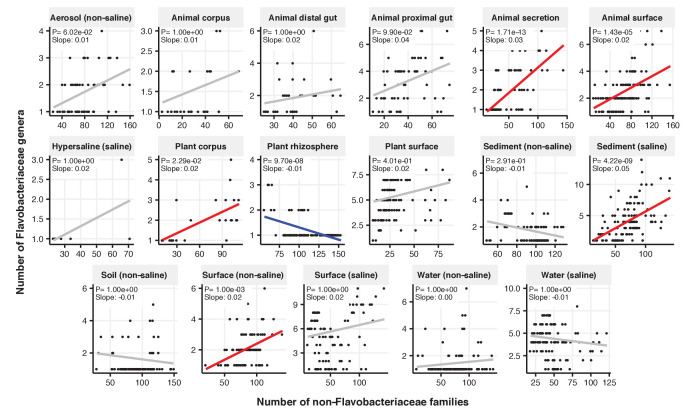
Focal-lineage diversity as a function of community diversity across biomes in Flavobacteriaceae.Linear models are shown for genera per family (y-axis) as a function of community diversity (non-focal families, x-axis) in each of the 17 environments (EMPO3 biomes). Only environments containing the focal lineage are shown. Significant positive diversity slopes are shown in red, negative in blue (linear models, p<0.05, Bonferroni corrected for 17 tests), and non-significant in grey.